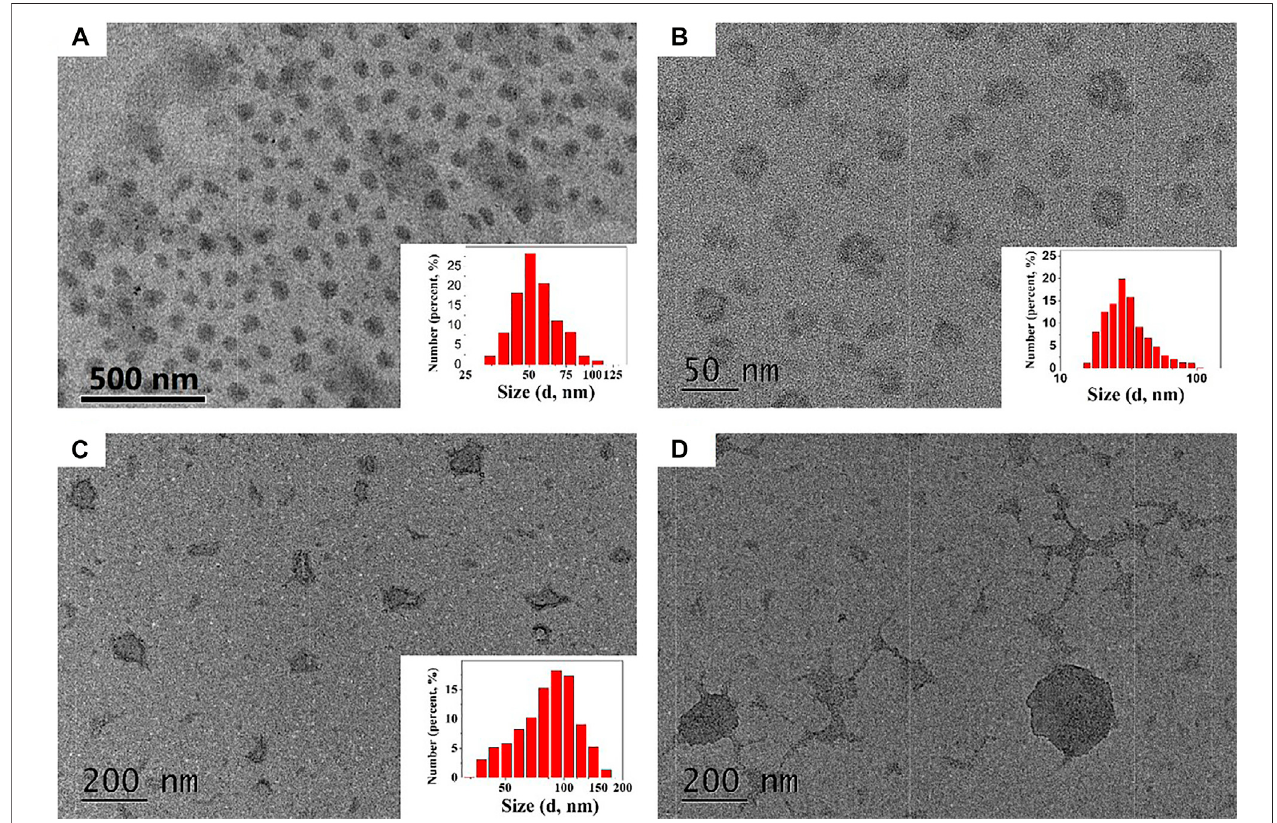
FIGURE 3 | (A) The TEM images of PEG-SS-AD NPs (PSA NPs). (B) The TEM images of PEG-SS-AD NPs incubated in 0.2 μ mol/L GSH alkalescent (pH ≈ 7.3) phosphate-bufferedsaline(PBS)solution. (C) TheTEMimagesofPEG-SS-ADNPsincubatedinacidic(pH ≈ 6.0)PBSsolution. (D)